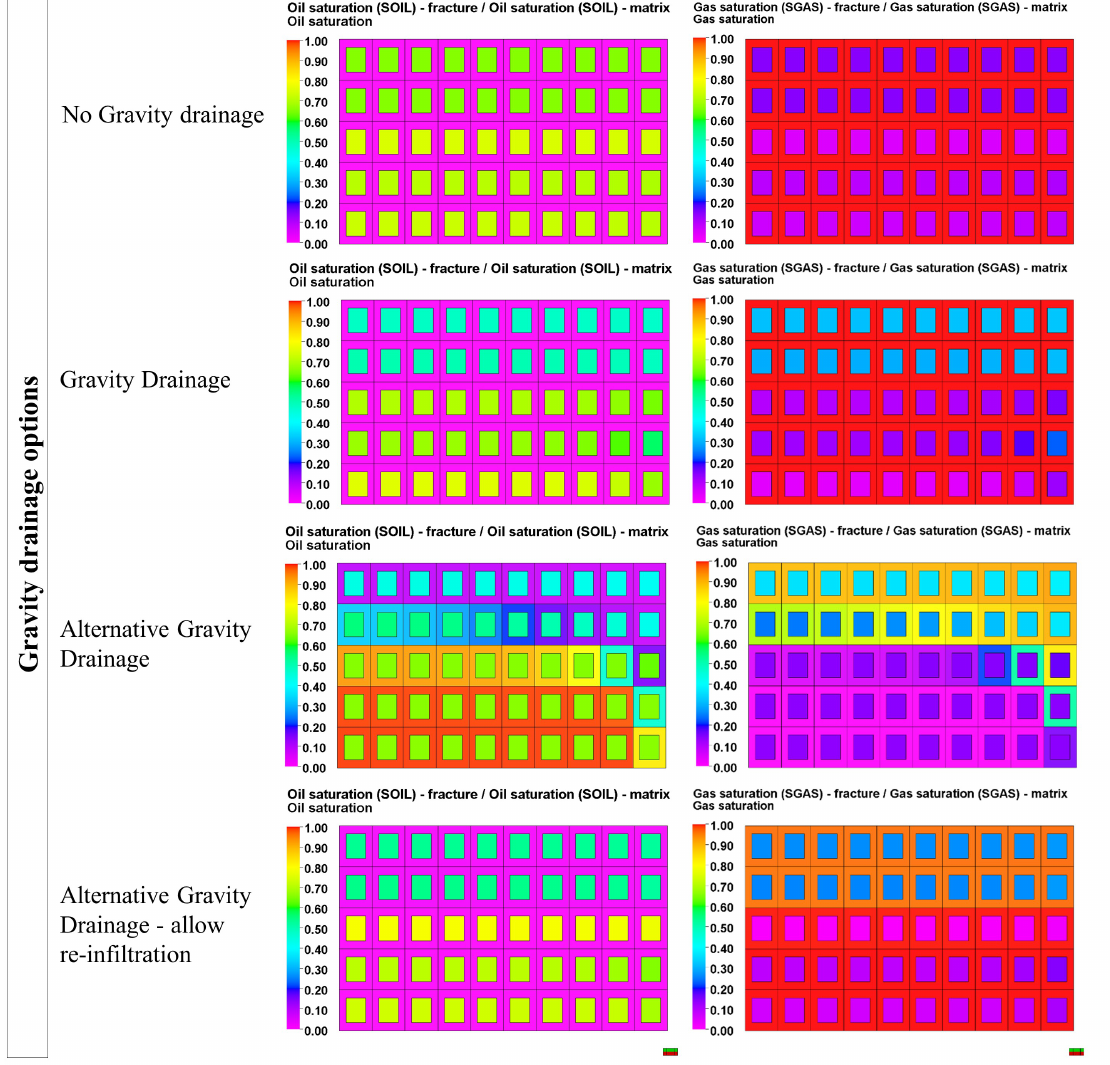
Figure 5. Oil and gas saturation profile at the end of simulation time, which illustrates how different gravity drainage options change the saturation profile. Furthermore, the saturation profile also highlighted the underestimation of the exchange rate between the matrix and the fracture domain when the gravity effect was not accounted for, or when inappropriate representation of the gravity mechanisms was